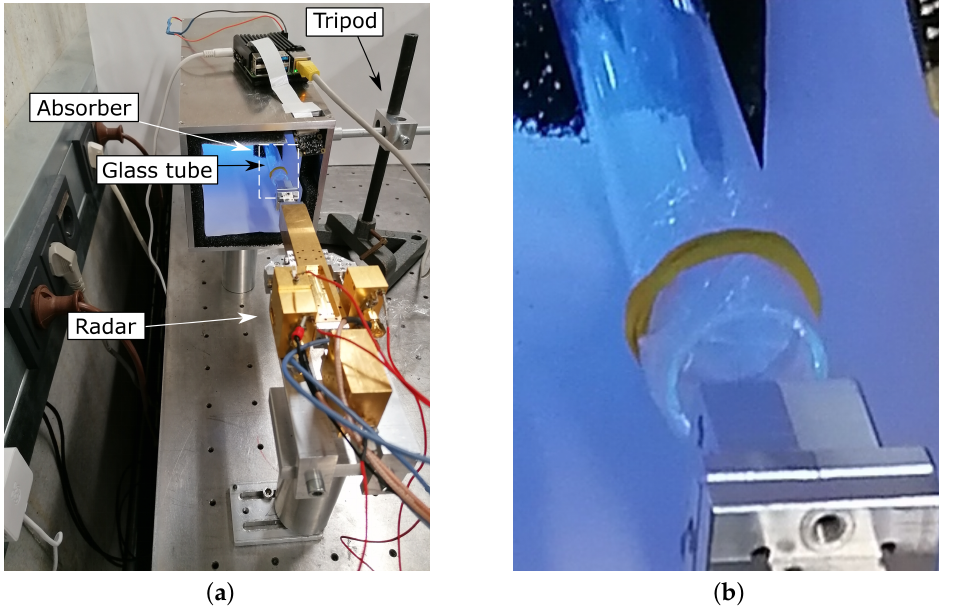
Figure 4. Experimental setup for mosquito measurements. ( a ) Full image. ( b ) Close-up of the area marked by the white dashed box in ( a